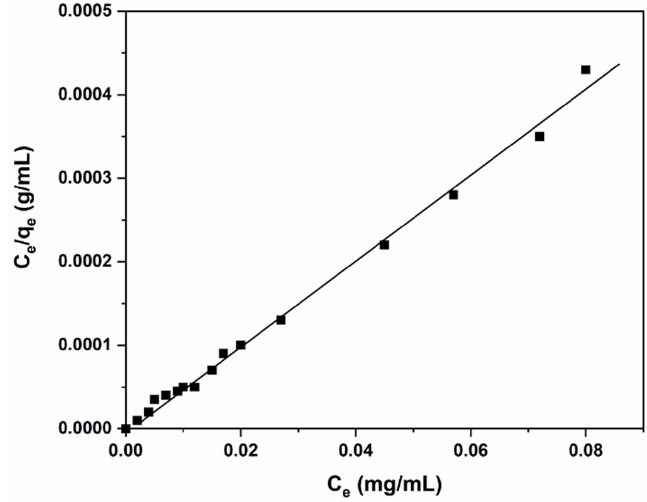
Figure 9. Isotherm model of the adsorption Cr (III) on 20 mg of C-PMMA/SnO 2c at pH 6.0, 25°C and at different concentrations (0–100 mg/L) of Cr (III).